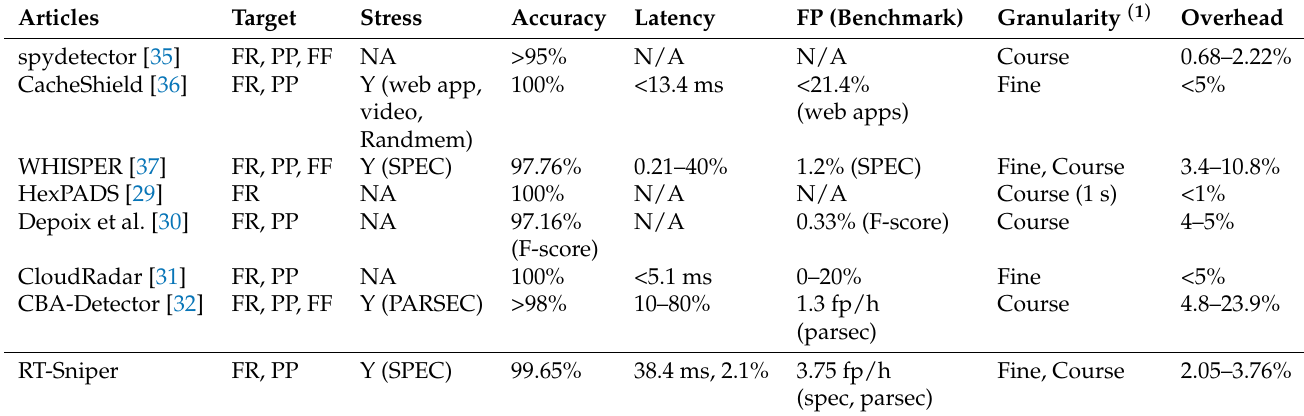
Table 5. Performance of previous works (1) Condition 2 is in which sampling granularity was evaluated. (Fine: less than several millisecond, Course: more than 10